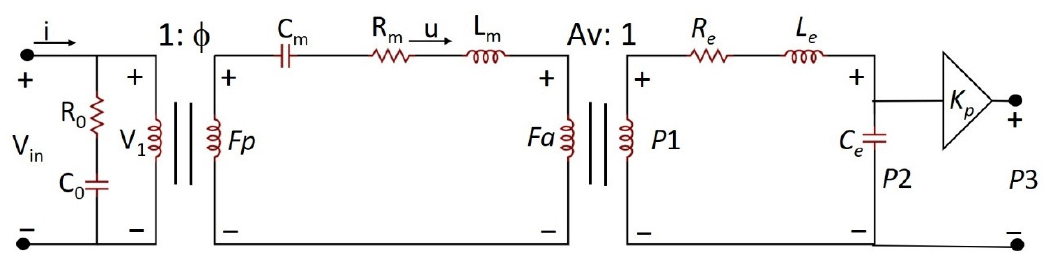
Figure 9. The proposed electric equivalent model of the developed PMUT integrated microliter-sized volume-tunable Helmholtz resonator.